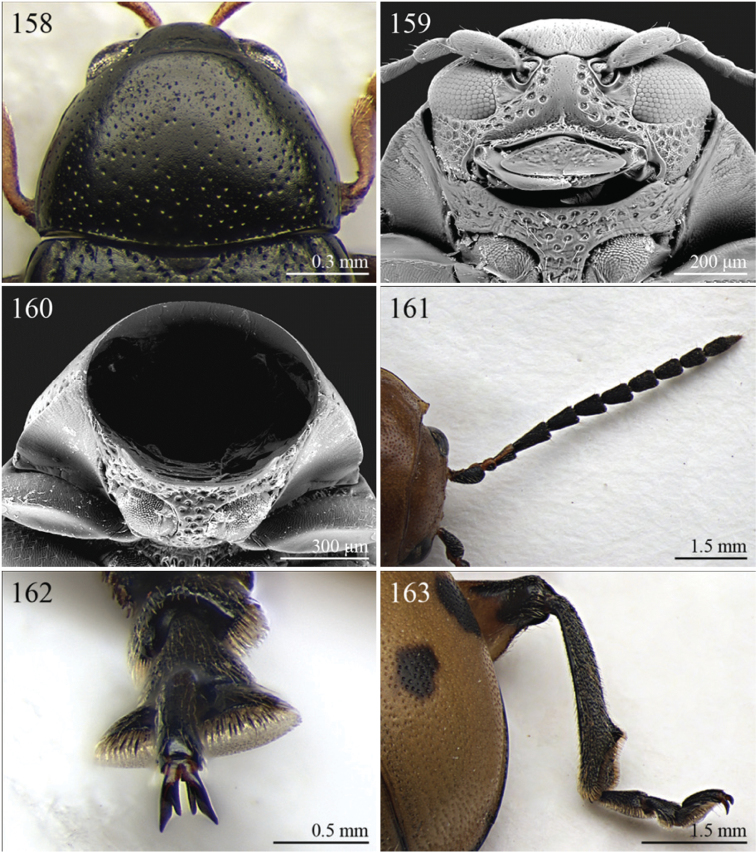
Morphological characters. 158
Collartaltica tenebrosa (Laboissière), head and pronotum in dorsal view 159 Ditto, head in ventral view 160 Ditto, prosternum 161
Diamphidia femoralis Gerstaecker, left antenna in dorsal view 162 Ditto, mesotarsus 163
Diamphidia nigroornata Stål, hind leg and elytral punctation.